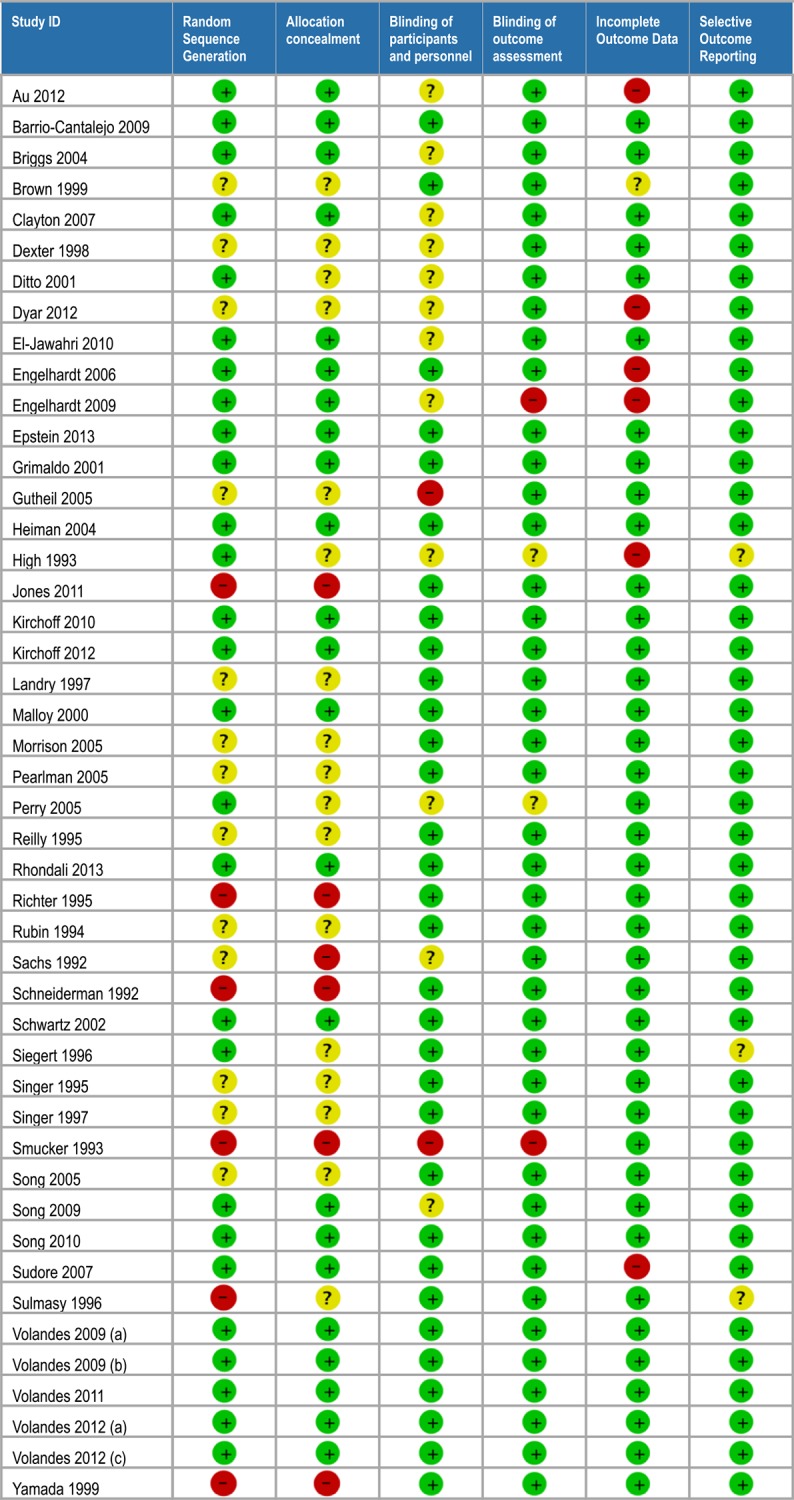
Risk of bias assessments for randomized controlled trials.